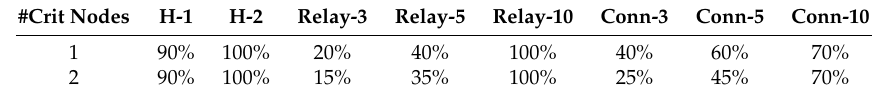
Table 3. Independent feature success rate for the top 3, 5 and 10 thresholds for the lifetime model.